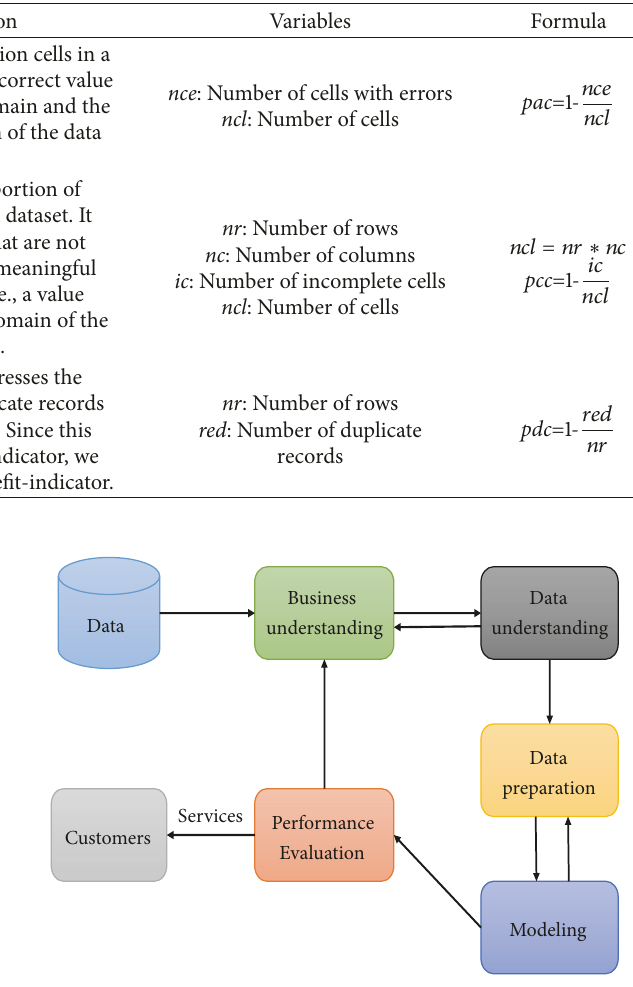
Figure 3: Big data business intelligence